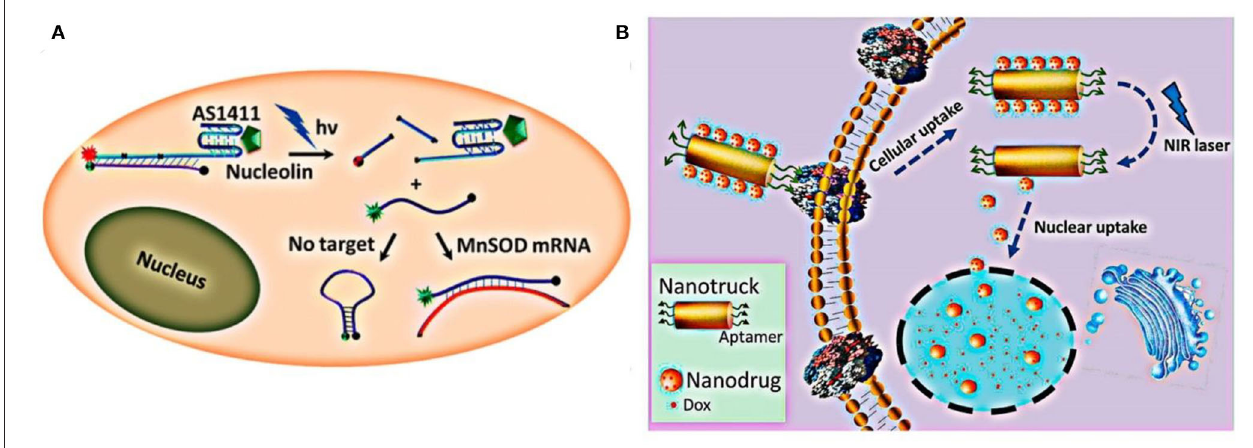
FIGURE 2 | Strategies for intracellular imaging of biological molecules (A) AS1411-based internalized strategy for mRNA imaging (Qiu et al., 2013); (B) Smart nanodrug delivery system with nuclear uptake (Qiu et al., 2015); Reproduced with the permission of American Chemical Society.